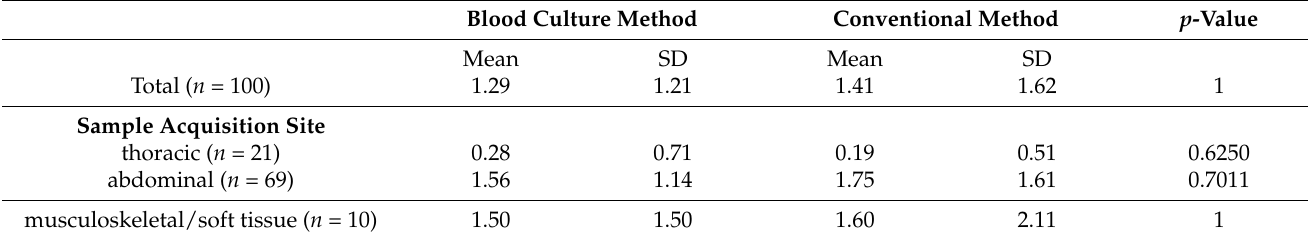
Table 2. Comparison of isolate rates between blood culture method and conventional method.